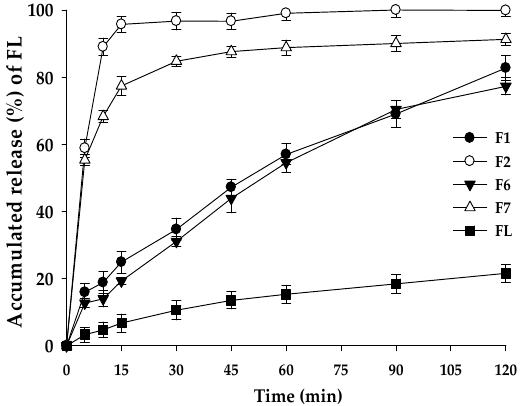
Figure 4. Dissolution profiles of F1, F2, F6, F7, and raw FL in pH 1.2 buffer. Values are represented as means ± SD ( n = 3).